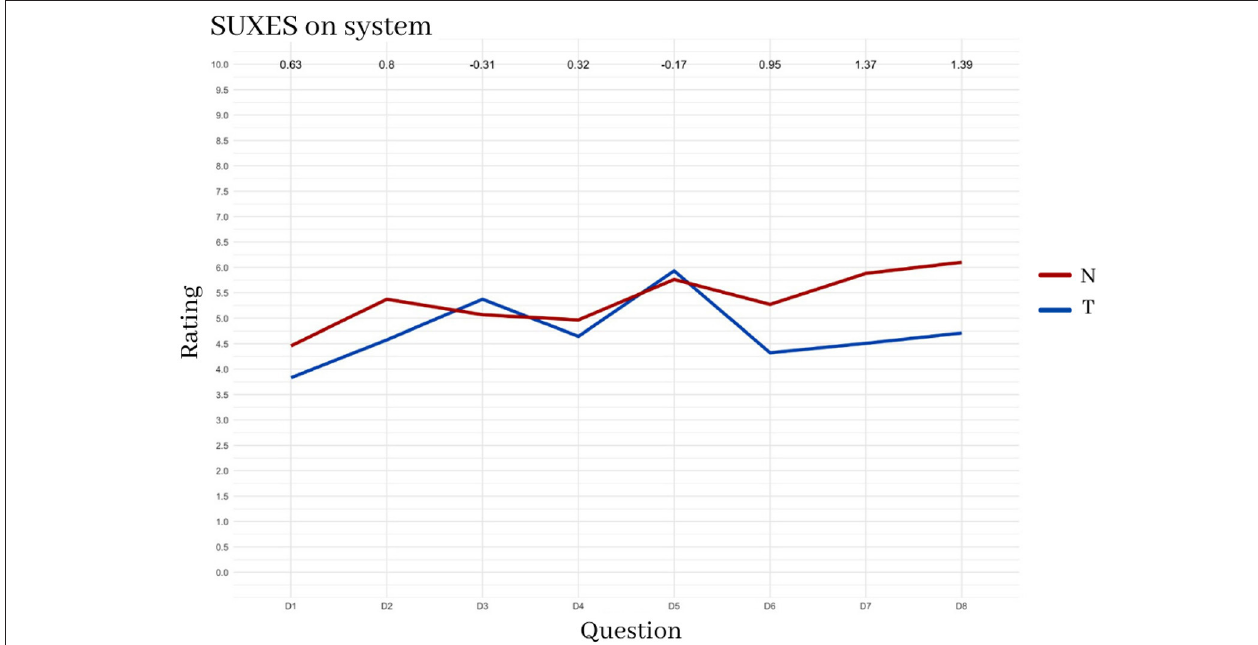
FIGURE 12 | System-related answers of the SUXES questionnaire in the two conditions N and T.